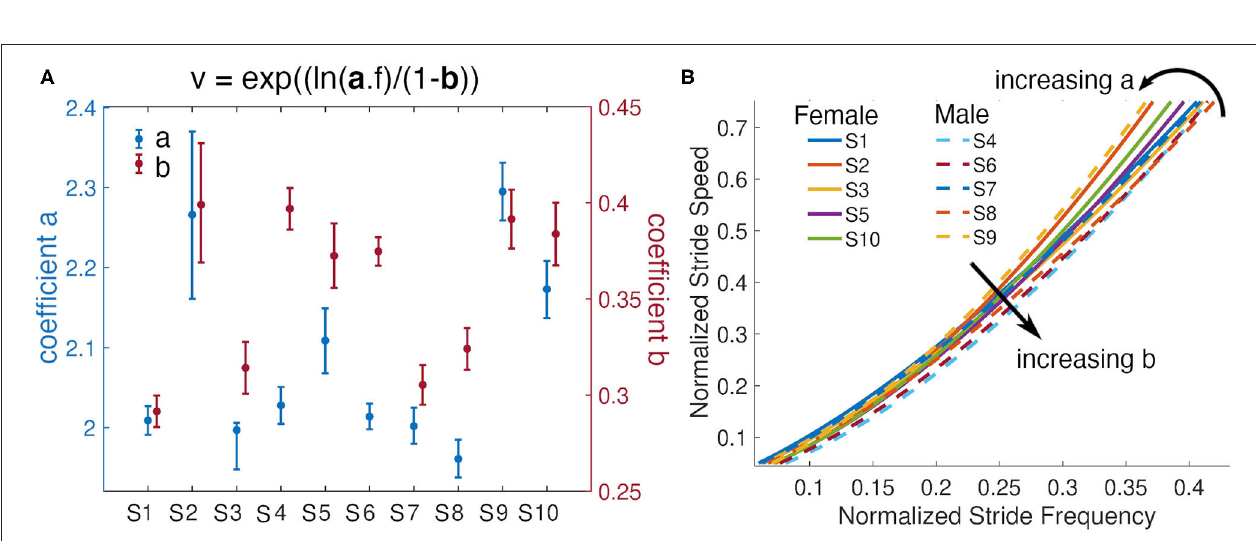
Frontiers in Sports and Active Living | www.frontiersin.org